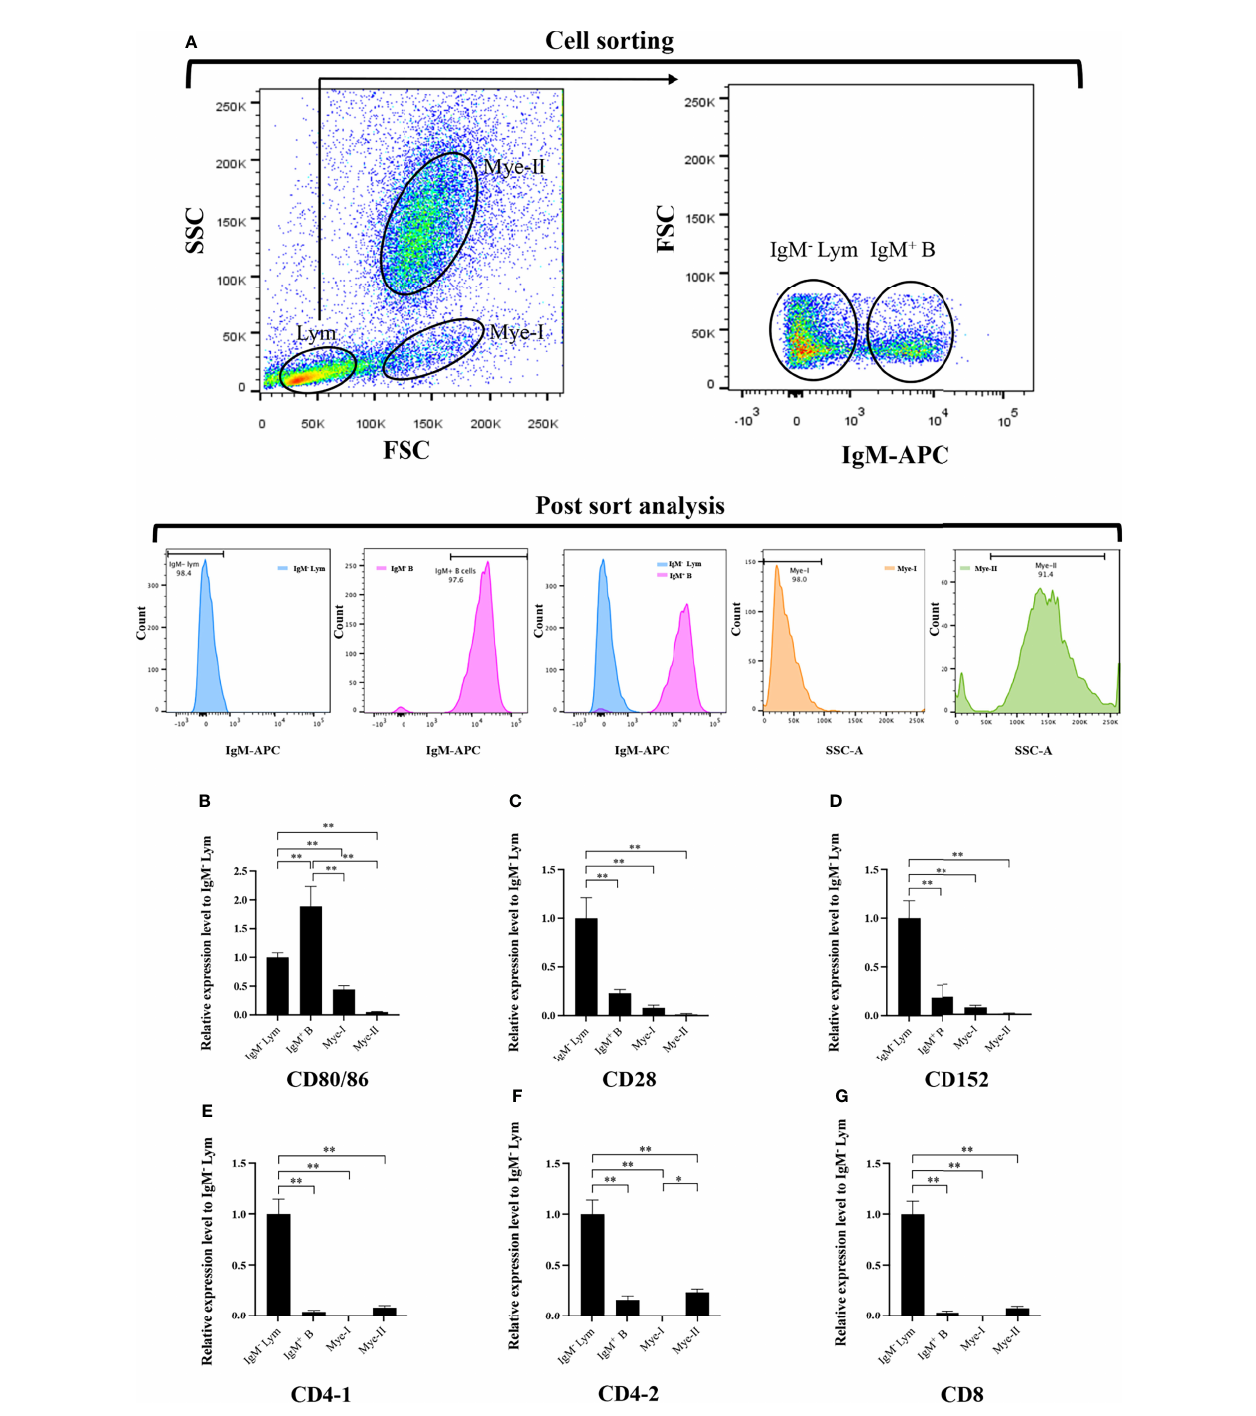
FIGURE 5 | Expression patterns of the grass carp CD80/86, CD28 , CD152 , CD4-1 , CD4-2 , and CD8 genes in head kidney leukocyte populations stained with mouse anti-grass carp IgM mAbs. (A) Flow cytometry analysis of the HKLs stained with mouse anti-grass carp IgM mAbs and APC-goat anti-mouse IgG Abs. Four different cell populations were sorted: IgM + B cells, IgM - lymphocytes (Lym), myeloid I subset cells (Mye I), and myeloid II subset cells (Mye II). The purity of the sorted cells was analyzed by FACS. (B – G) The mRNA expression levels of CD80/86 (B) , CD28 (C) , CD152 (D), CD4-1 (E), CD4-2 (F) , and CD8 (G) genes in the four different cell populations were detected using qPCR. One representative result is represented by the fl ow cytometry dot plot. The mRNA expression levels were analyzed by qPCR and normalized against b -actin using the 2 − D Ct method. The p value was calculated using ANOVA with the LSD post hoc test (* p < 0.05, ** p < 0.01). Data are presented as mean ± SEM (n = 5 fi